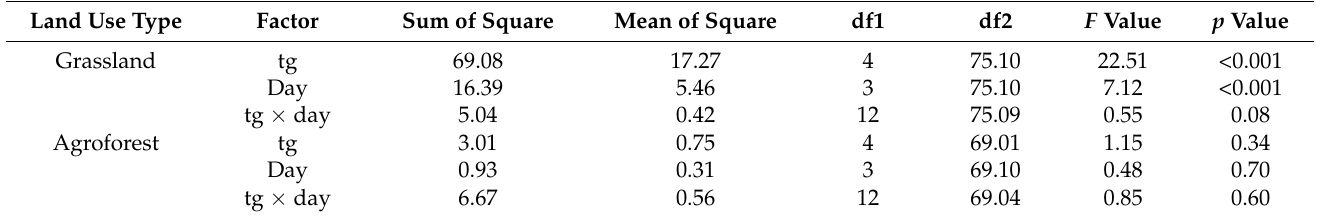
Table 5. Linear mixed-effect model table of type III error for the effect of trophic group, sam- pling day and their interaction on the incorporation of 13 C into nematode tissue in grassland and agroforest